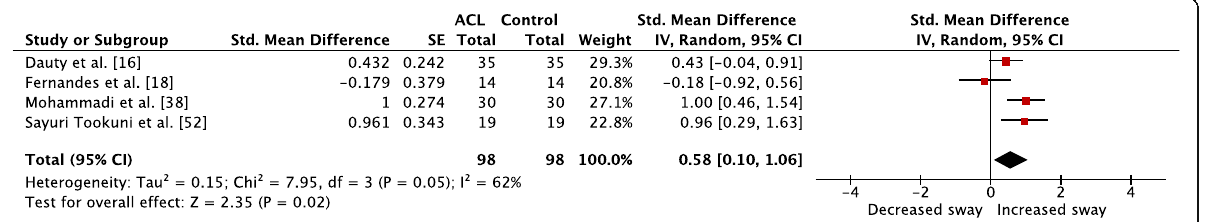
Fig. 3 Forest plot comparison of anteroposterior sway magnitude between the ACL-injured and ACL-matched control leg. Std . standardized, SE standard error, IV inverse variance, CI confidence interval, df degrees of freedom, ACL anterior cruciate